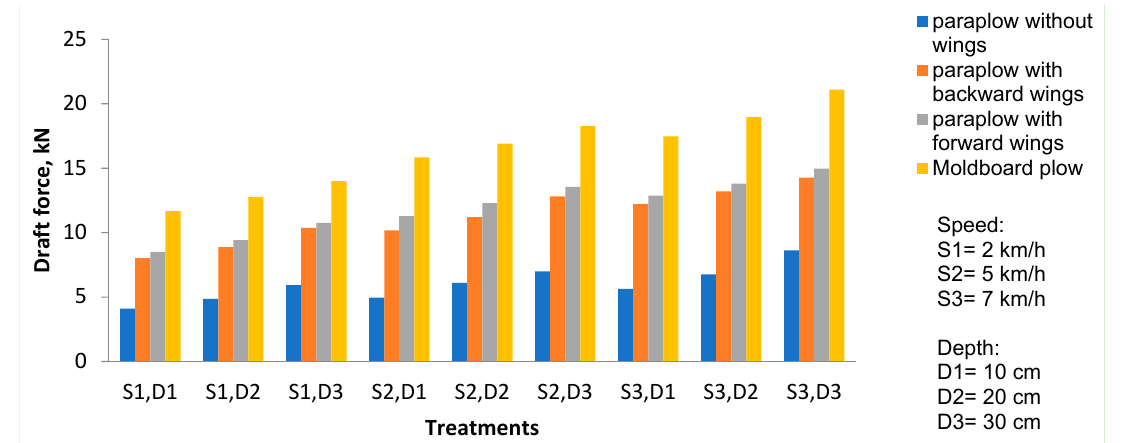
Figure 4. Mean draft forces under different implements and treatments, S and D show speed and depth, respectively.